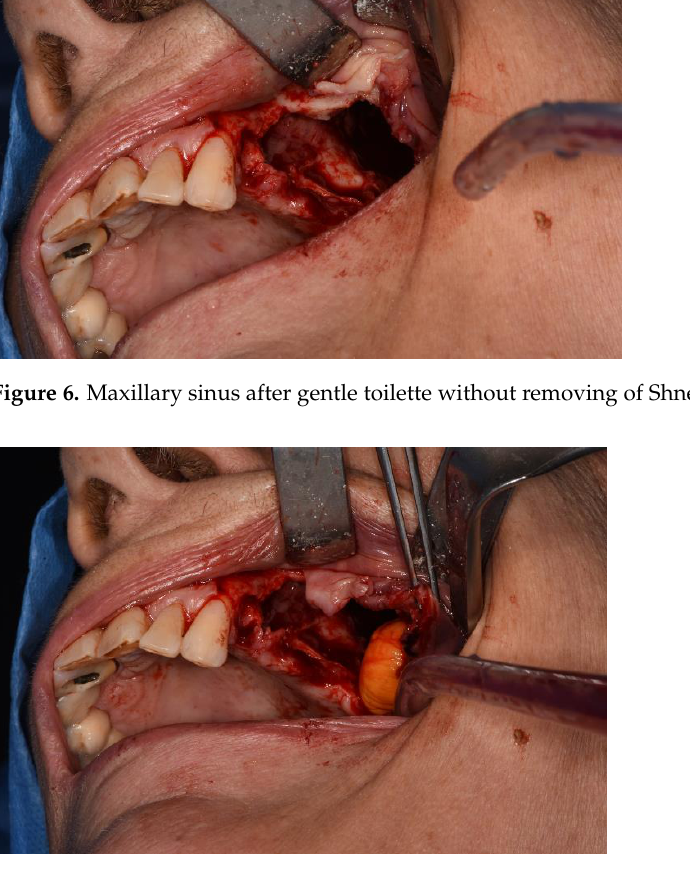
Figure 7. Buccal fat paddle isolation.